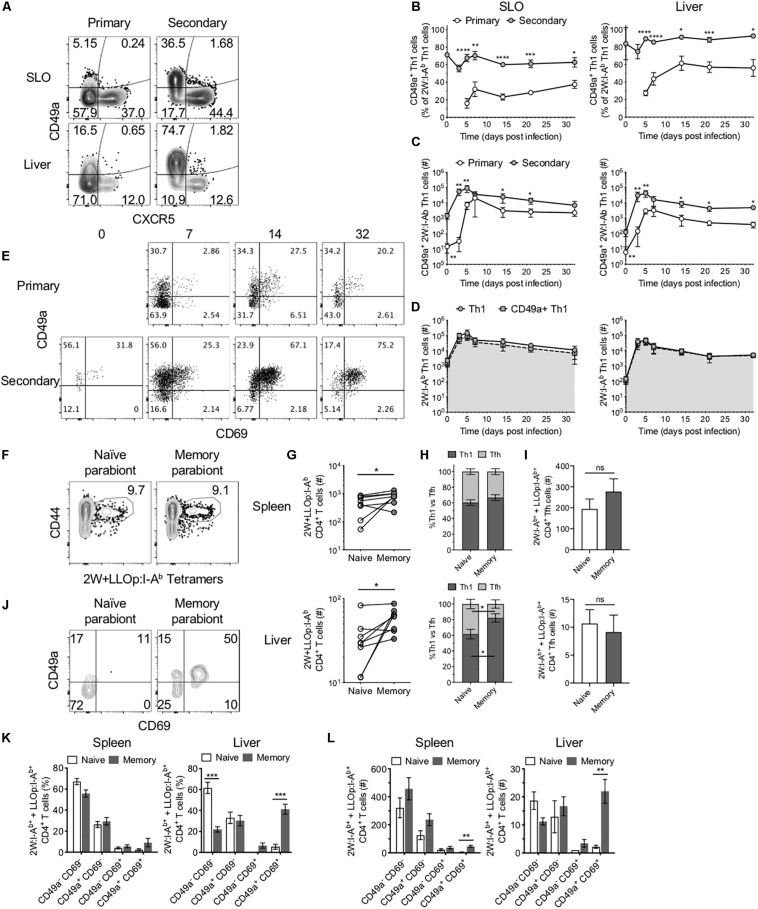
CD49a+ cells dominate the secondary Th1 CD4+ T cell response and maintain residence in the liver. (A) Representative flow cytometry plots demonstrating CXCR5 and CD49a expression on 2W:I-Ab-specific CD4+ cells, excluding Foxp3+ Tregs, in the SLOs and liver at 5 dpi following primary or secondary Lm infection. Frequency (B) and number (C) of CD49a+ Th1 cells in the SLOs and liver. (D) Number of 2W:I-Ab-specific Th1 cells (circles) or 2W:I-Ab-specific CD49a+ Th1 cells (squares) in the SLOs and liver following secondary Lm infection. (E) Representative flow cytometry plots demonstrating CD69 and CD49a expression on 2W:I-Ab-specific CD4+ Th1 cells in the liver at 0, 7, 14, and 32 dpi following primary or secondary Lm infection. (F,G) Lm-immune and naïve mice were conjoined via parabiosis >110 days after Lm infection. Parabiont donors were analyzed 18–19 days after parabiosis. (F) Representative flow cytometry plots demonstrating the presence of 2W:I-Ab and LLOp:I-Ab-specific CD4+ T cells in the spleens of a parabiont pair. (G) Number of 2W:I-Ab and LLOp:I-Ab-specific CD4+ T cells in the spleens and livers of parabiont pairs. (H) Frequency of 2W:I-Ab and LLOp:I-Ab-specific CD4+ T cells exhibiting a Th1 or Tfh phenotype in the spleens and livers of parabiont pairs. (I) Numbers of 2W:I-Ab and LLOp:I-Ab-specific CD4+ Tfh cells in spleens and livers of parabiont pairs. (J) Representative flow cytometry plots demonstrating CD69 and CD49a expression on 2W:I-Ab and LLOp:I-Ab-specific CD4+ T cells in the livers of a parabiont pair. Frequency (K) and numbers (L) of 2W:I-Ab and LLOp:I-Ab-specific CD4+ Th1 cells expressing combinations of CD69 and CD49a [as in panel (J)] in the spleens and livers of parabiont pairs. Data are compiled from two to three independent experiments per time point with n = 1–4 mice per experiment (A–E). Eight parabiont pairs were analyzed (F–L). *P < 0.05, **P < 0.01, ***P < 0.001, ****P < 0.0001 as determined by unpaired Student’s t-test (B), Mann Whitney U test (C), paired t-test (G), two-way ANOVA followed by Sidak’s multiple comparison test (H,I), or matched two-way ANOVA followed by Sidak’s multiple comparison test (K,L). Bars represent mean ± SEM [except panel (C), where bars represent mean ± SD].